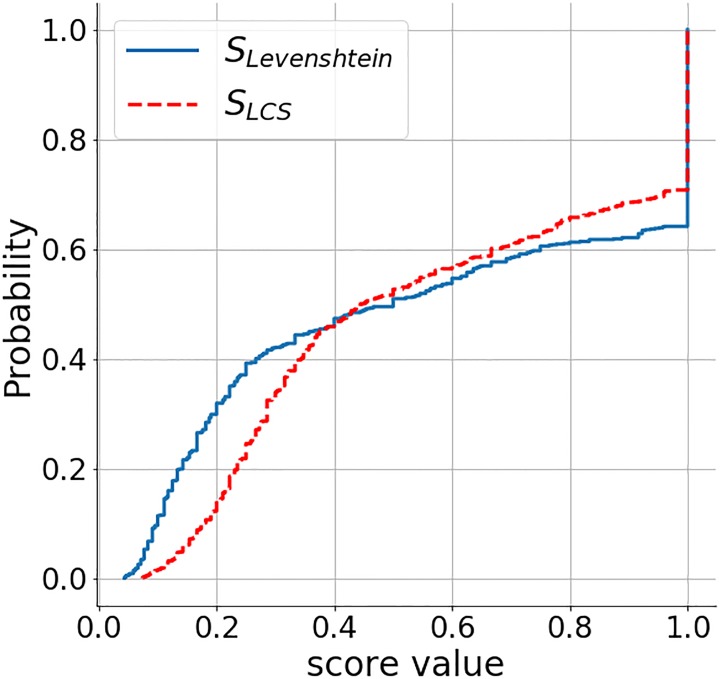
CDF of SLCS, SLD (proximity threshold ≤ 50m).